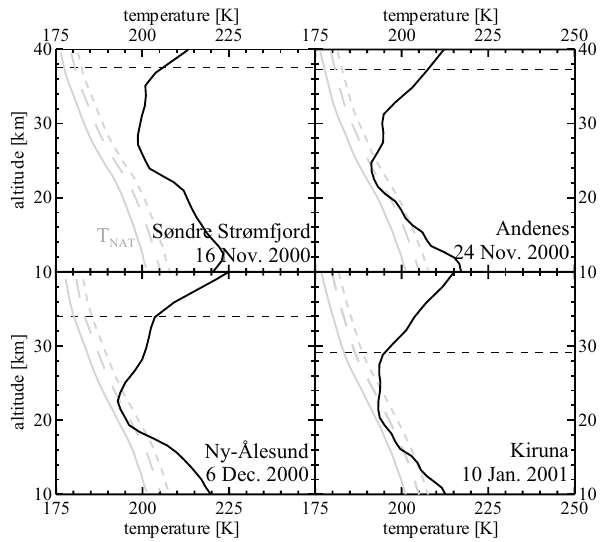
Fig. 8. Temperature profiles from ECMWF data for the observation of the aerosol layer displayed in Fig. 2. T NAT is shown for com- parison for typical H 2 O and HNO 3 concentrations and increased concentrations (long dashed: [ H 2 O ] + 3 ppmv, [ HNO 3 ]· 3; short dashed: [ H 2 O ] + 6 ppmv, [ HNO 3 ]· 6). The horizontal dashed lines show the altitude of the aerosol